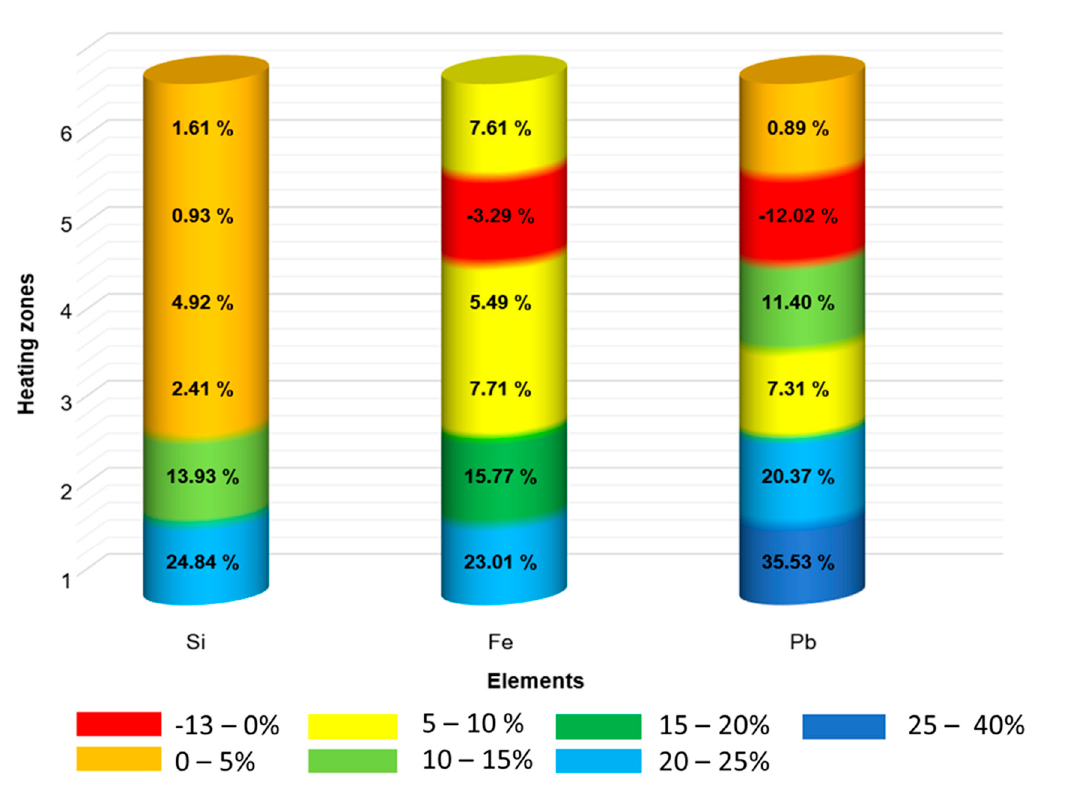
Figure 7. Reduction factor over the heating zones of silicon, iron, and lead at a cooling rate of 10 K/h and a temperature gradient of 20 K.